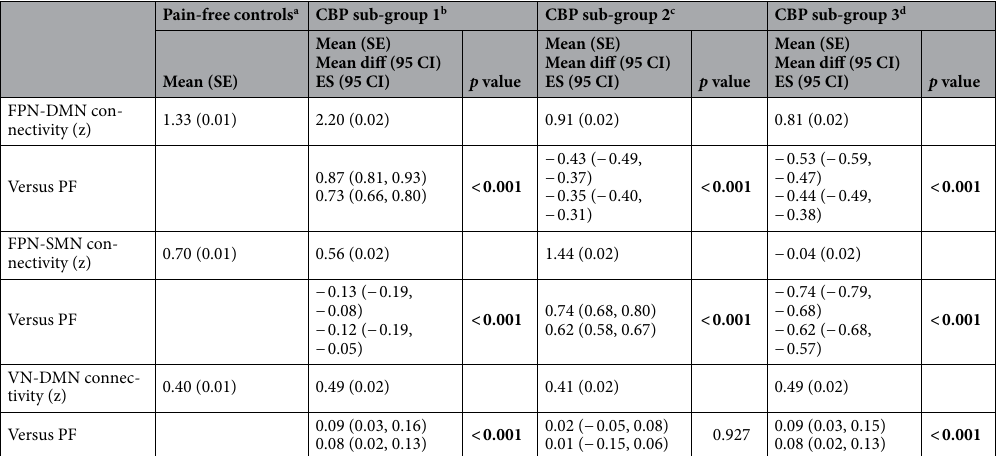
Table 4. Results of the Analysis of Covariance (ANCOVA) sub-groups derived from brain function variables. Data are presented as adjusted mean (standard error). Adjusted mean differences and 95% confidence interval (95 CI) are reported. Effect sizes and 95% confidence intervals were calculated using standard formulae. All data were adjusted for age and sex. p value s were adjusted for multiple comparisons using Tukey HSD method. PF pain-free, 95 CI 95% confidence interval, ES effect size, FPN frontoparietal network, DMN default mode network, SMN sensorimotor network, VN visual network. Significant values are in [bold]. a Pain-free individuals (n = 14,927; 78.2%). b CBP sub-group 1: high FPN-DMN connectivity (n = 1347; 7.1%). c CBP sub- group 2: high FPN-SMN connectivity (n = 1335; 7.0%); d CBP sub-group 3: low FPN-DMN and FPN-SMN network connectivity (n = 1474; 7.7%).